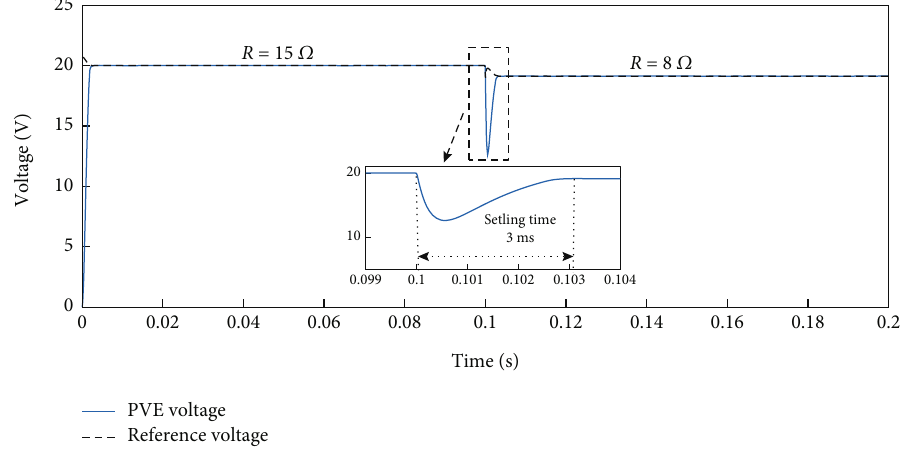
Figure 20: Response of the PVE to an abrupt change in load resistance